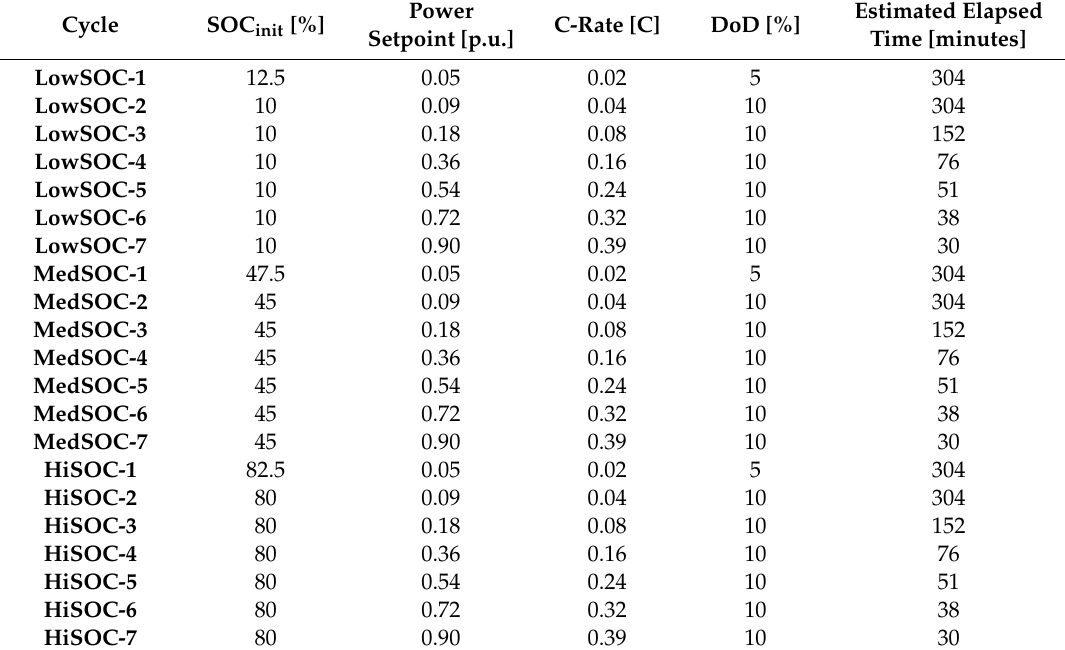
Table 6. Layout of test Set